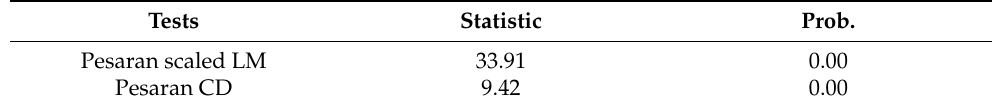
Table 3. Cross Sectional Dependency